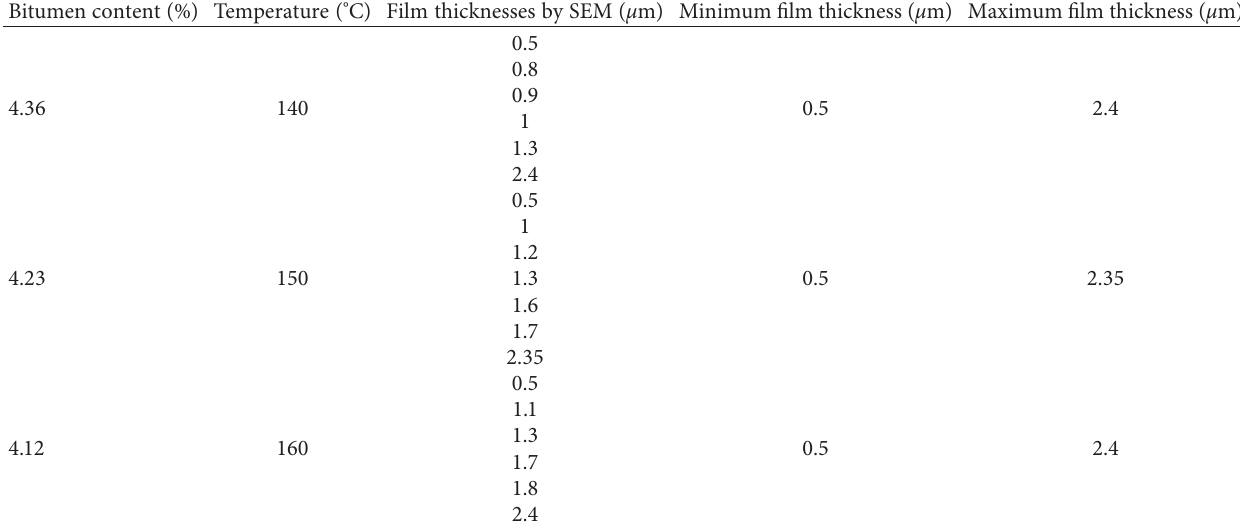
Table 8: Microscopically measured film thicknesses at optimized binder content of 4.36% to 4.12% and temperature 140 ° C to 160 ° C.